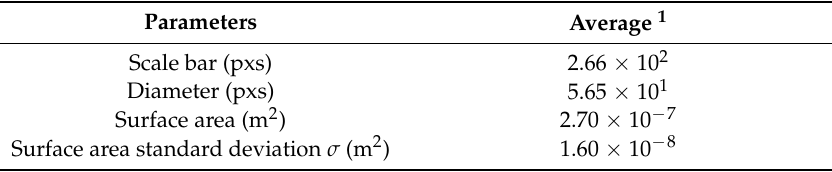
Table 4. Results for threshold selection